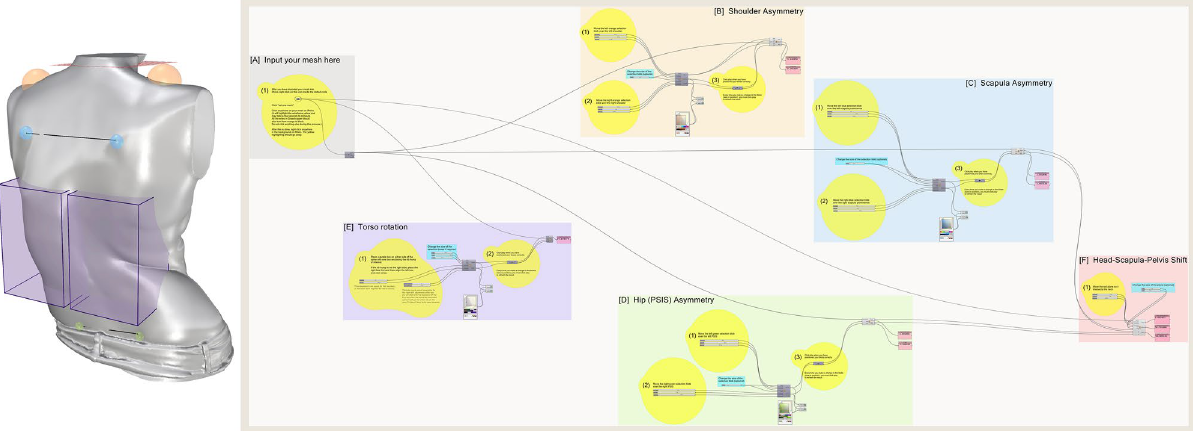
Fig 3. Rhino viewport (left) with Grasshopper user interface (right). The Rhino viewport shows a processed 3D model of an AIS patient (Lenke type 5). ROIs are shown placed in the correct positions for measurement. The Grasshopper modules are colour matched to the ROIs for each anatomical feature visible in the Rhino viewport—input (grey), shoulder (orange), scapula (blue), hip (green), torso rotation (purple), head-pelvis shift